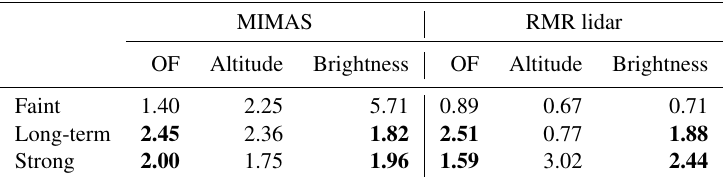
Figure 4. Mean local time variations of PMC occurrence frequency (a, b) , altitude (c, d) , and brightness β max (e, f) for July in the period from 2003 to 2013 at ALOMAR for faint (red), long-term (blue), and strong (green) clouds (for details see text). Panels (a, c, e) show model results for 67–71 ◦ N, 10–20 ◦ E, panels (b, d, f) show lidar observations from ALOMAR. The lines represent the sum of four harmonic fits using periods of 24, 12, 8, and 6h to hourly mean values. Numbers in the figure legends are daily mean values. Brightness ranges for cloud classes are scaled down by a factor of 4 for MIMAS results. Note the different scaling of the brightness axis for model and lidar data. Table 3. Ratio of diurnal to semidiurnal amplitudes ( A 24 /A 12 ) of harmonic fits to the modeled and observed occurrence frequency (OF), altitude, and brightness. The values are calculated for different cloud classes (for details see text) for July months in the period from 2003 to 2013 at ALOMAR according to Fig. 4. Bold numbers mark values that agree within the relative uncertainty of about 15% (confidence level of